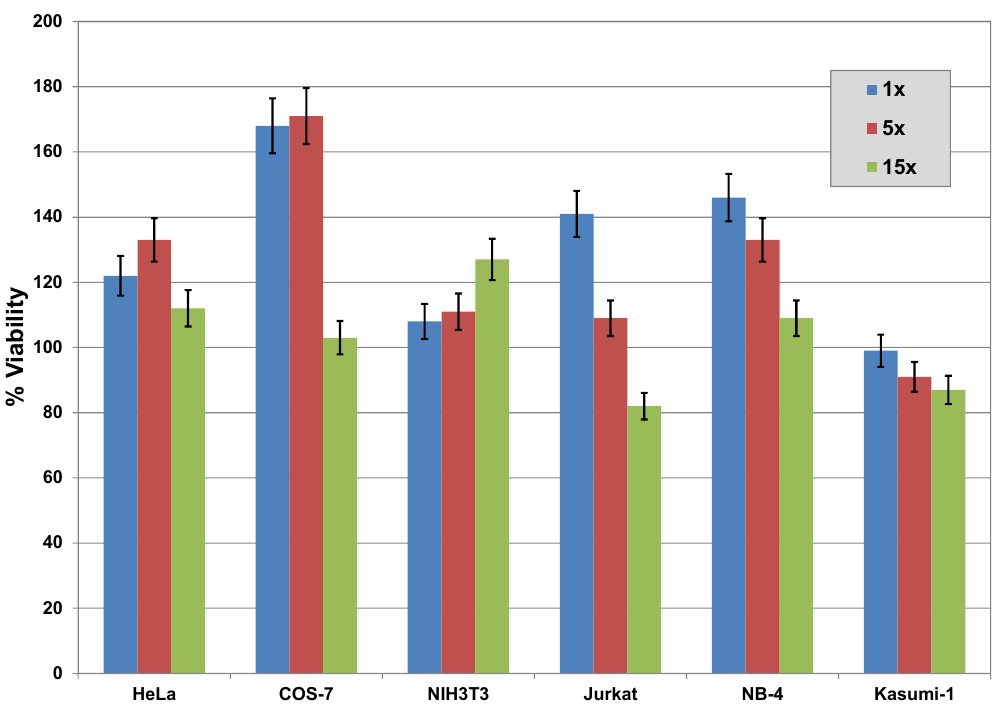
Figure 7. Influence of increasing concentrations of JBS-Proteoducin on viability of different cell lines. Viability of different adhesion and suspension cell lines was measured by colorimetric tetrazolium (MTT) assay. The CPP cocktail is used as recommended one- fold, five-fold, and 15-fold (15×) higher concentration. Cell lines show different sensitivity to JBS-Proteoducin. Cell viability is reduced only marginally, even in high concentrations. Except for Kasumi-1 cells the CPP cocktail enhances cell viability in all cell lines at commonly used concentrations.